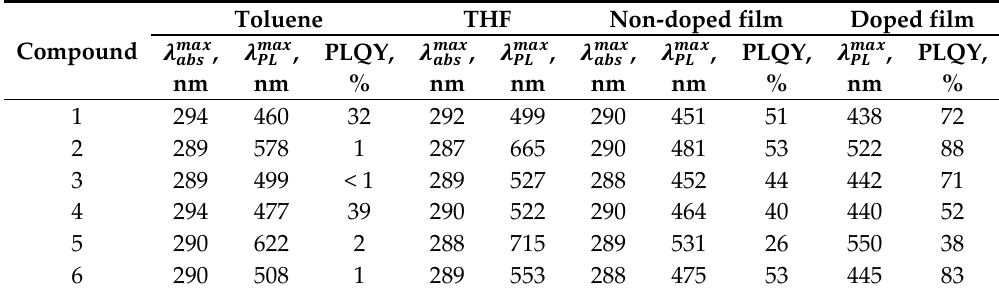
Table 3. Photophysical characteristics of compounds 1 –